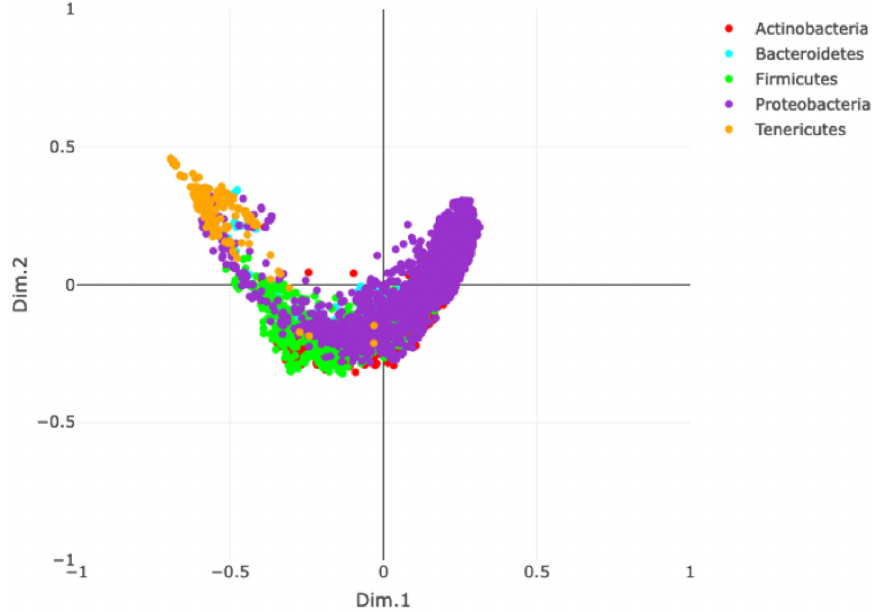
Fig 8. MDS plot of a selected set of bacteria at phylum level, obtained by the SP graph kernel.